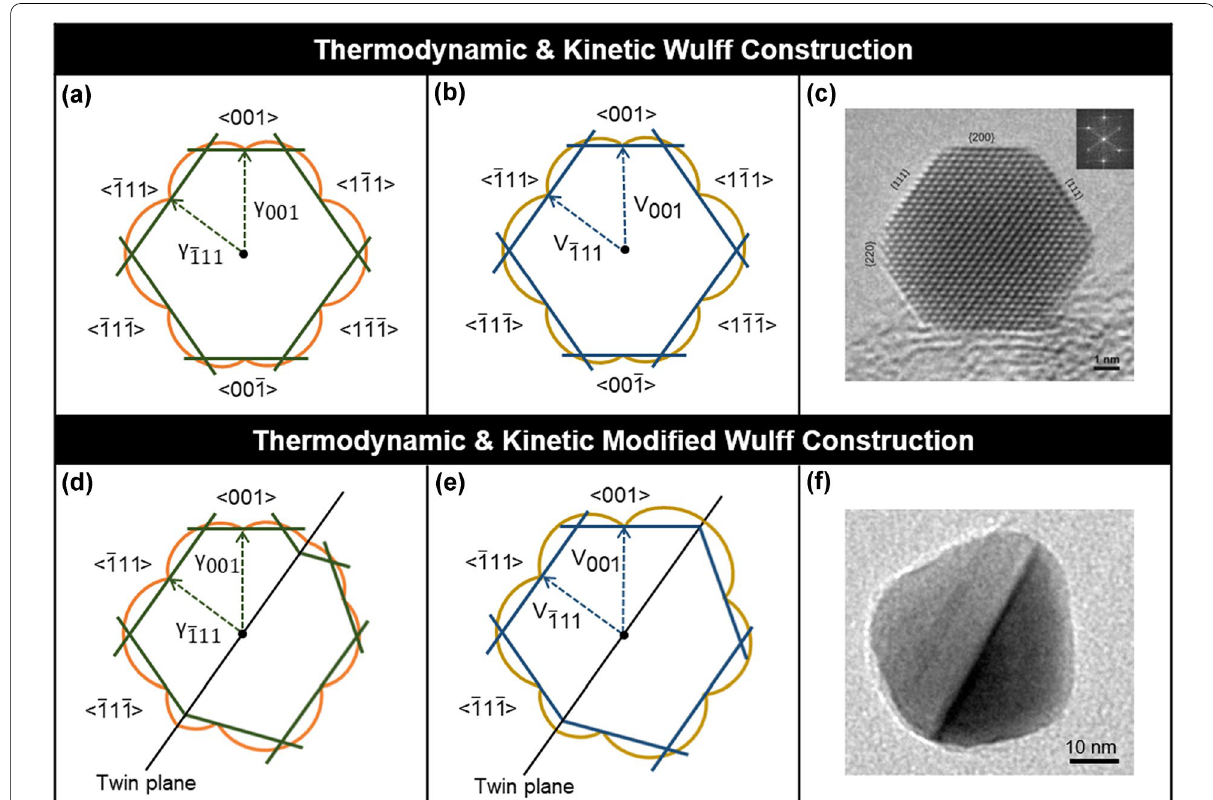
Fig. 2 Single crystal and modified (twinned) Wulff constructions. Gamma and v-plots viewed along < 110 > for the ( a ) thermodynamic, ( b ) kinetic, ( d ) thermodynamic modified and ( e ) kinetic modified with re-entrant enhancement Wulff constructions. γ and v correspond to surface energy and growth velocity, respectively, and the twin energy/twin growth velocity is considered to be negligible. Examples of TEM images of ( c ) a single crystal AgI octahedron, reprinted from [25] with permission from Elsevier, and ( f ) a twinned Ag right bipyramid, adapted with permission from